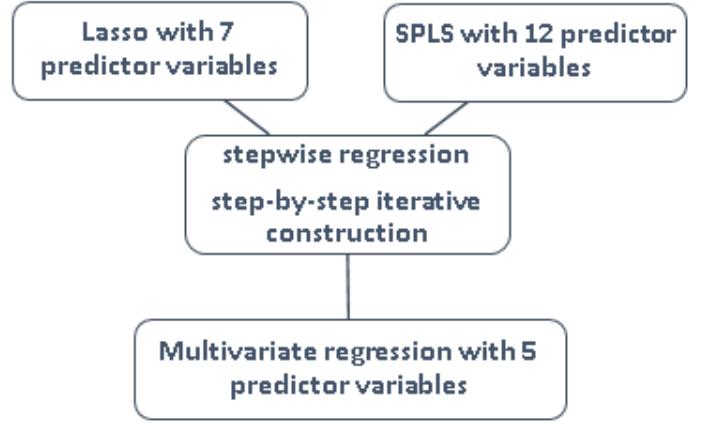
Figure 6. Building process of the final forecast model.